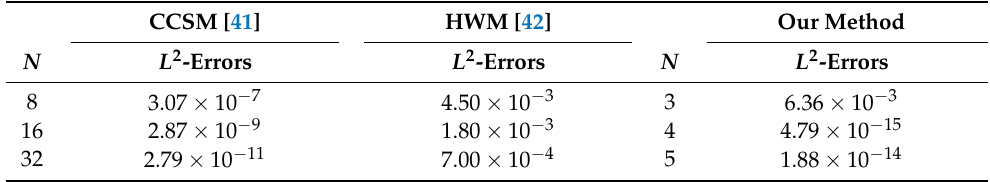
Table 2. Comparison of L 2 -errors of our algorithm at υ 1 = 0.25 and b = 2 for distinct N with the CCSM [41] and HWM [42] for Example